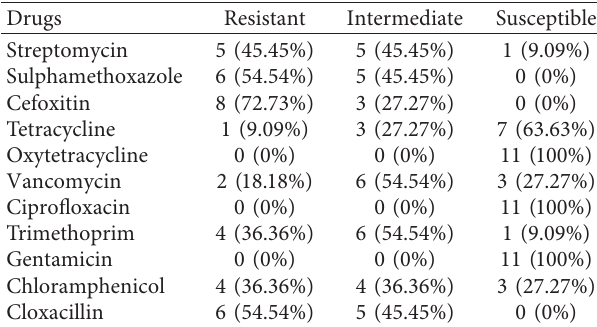
Table 3: Antimicrobial susceptibility pattern of E. coli O157:H7